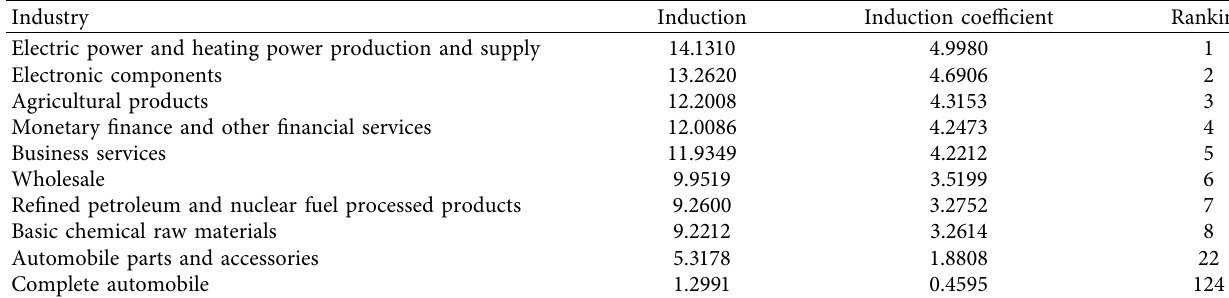
Table 8: Ranking of induction and induction coefficient of automobile industry chain.